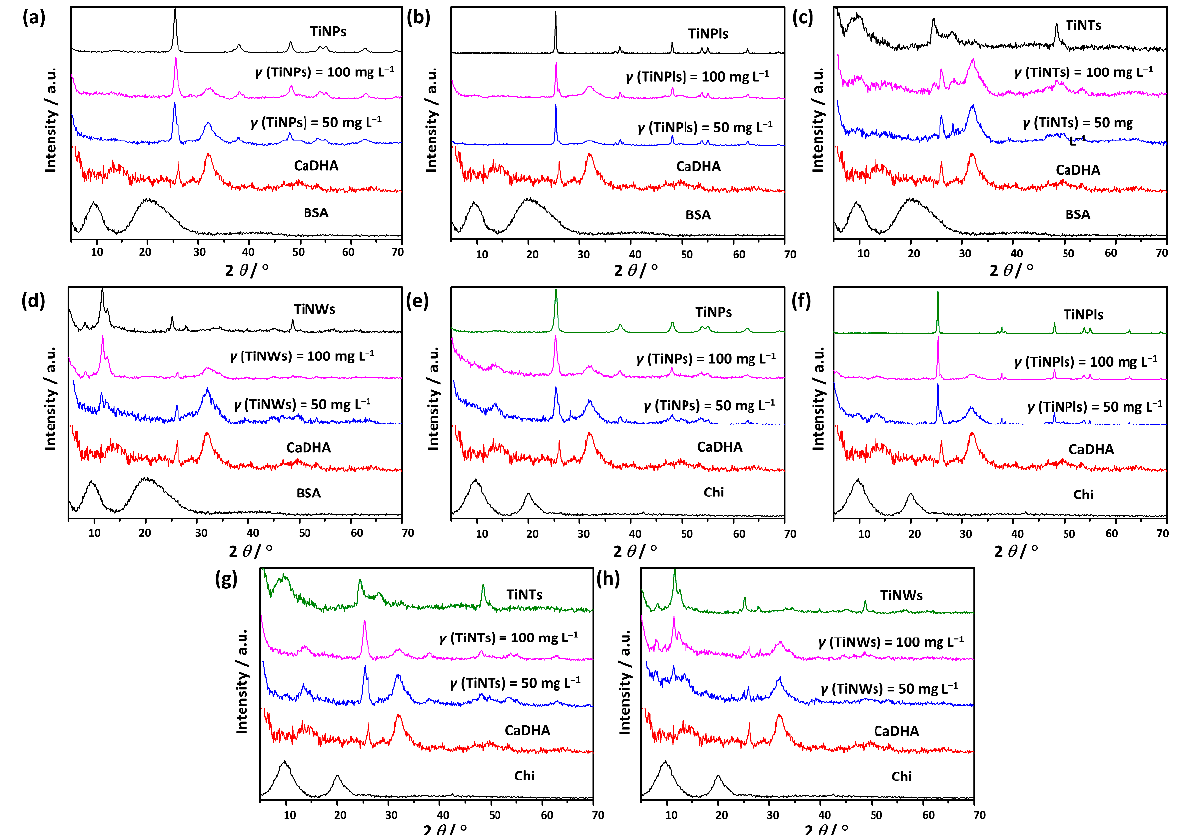
Figure 5. PXRD patterns of the precipitates obtained in the control system (CaDHA) and in the presence of ( a – d ) 50 mg L − 1 bovine serum albumin (BSA) or ( e , f ) 15 mg L − 1 of chitosan (Chi) and different concentrations of TiO 2 nanomaterials: ( a , e ) TiO 2 nanoparticles (TiNPs), ( b , f ) TiO 2 nanoplates (TiNPls), ( c , g ) titanate nanotubes (TiNTs), ( d , h ) nanowires (TiNWs. c (CaCl 2 ) = c (Na 2 HPO 4 ) = 4 × 10 − 3 mol dm − 3 , pH init = 7.4, ϑ = (25 ± 0.1) °C.